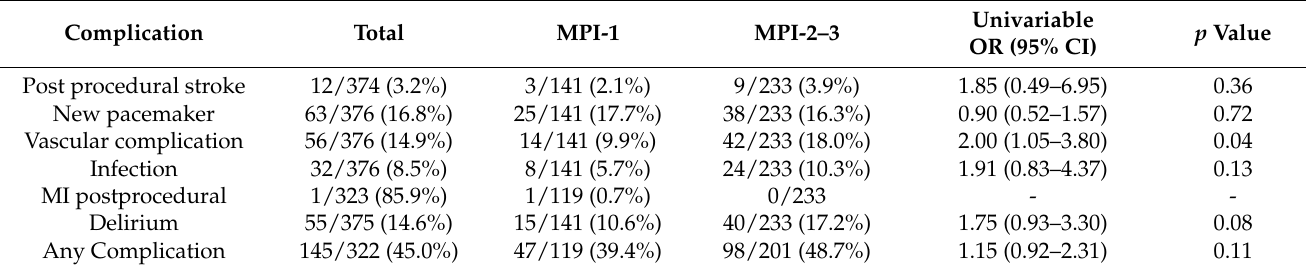
Table A1. Univariate logistic regression analysis for secondary